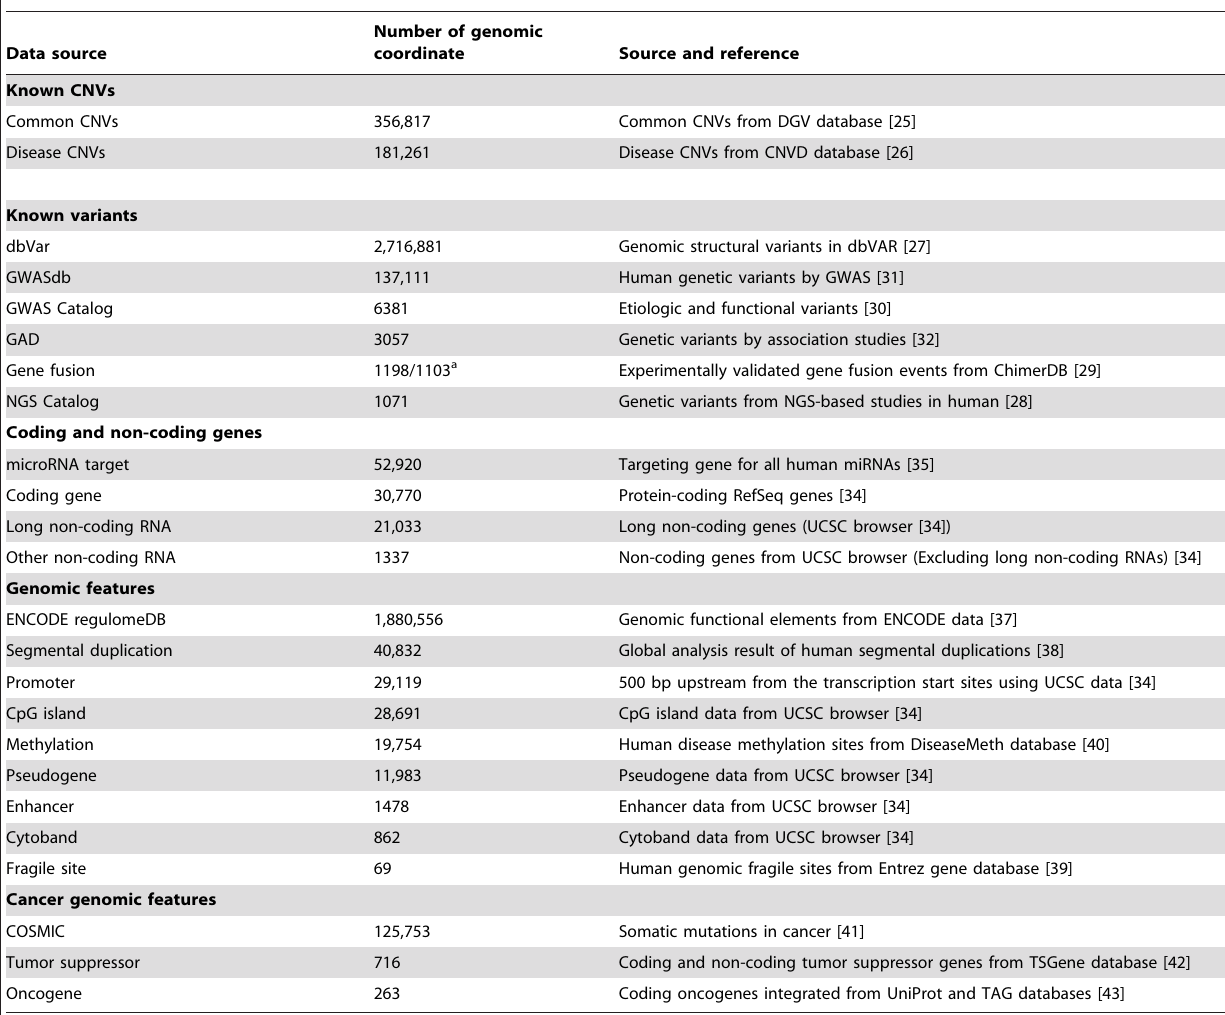
Table 1. All the annotations in CNVannotator web